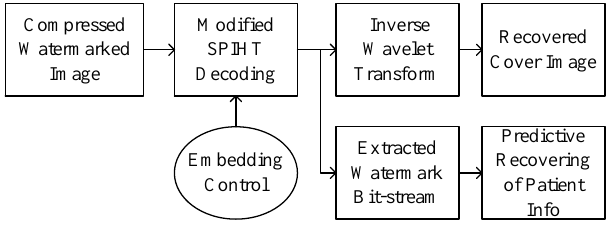
Fig. 3 The flow chart of the proposed watermark extraction